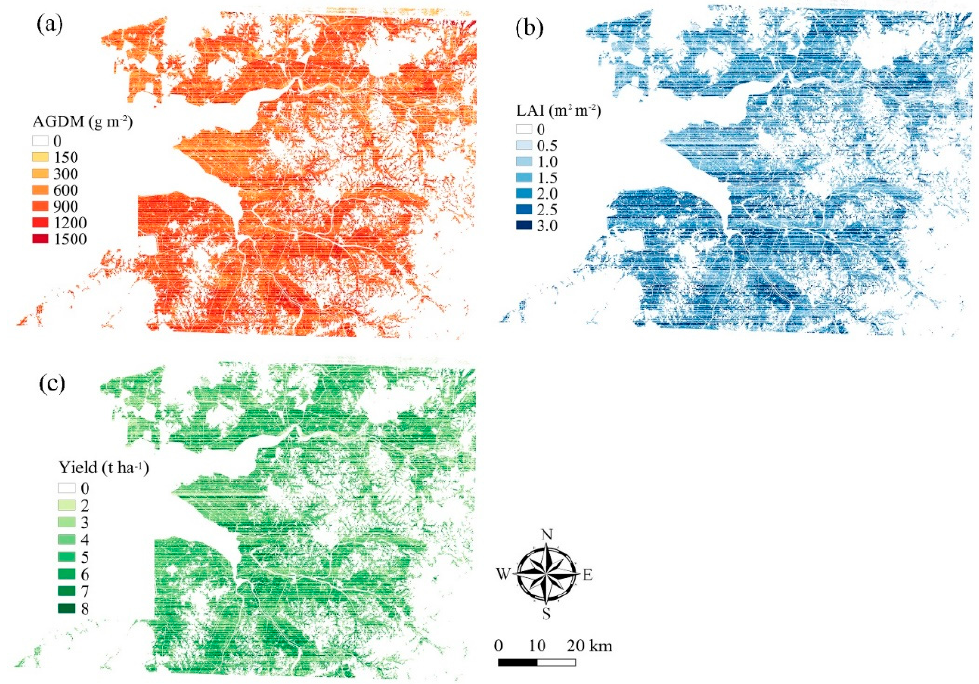
Figure 7. Simulated regional variations in above ground dry mass, AGDM ( a ) and leaf area index, LAI ( b ) at 100 days after transplanting and yield ( c ) of rice in Gimje in 2014. The data were simulated using RapidEye satellite imageries with a 5-m ground resolution.